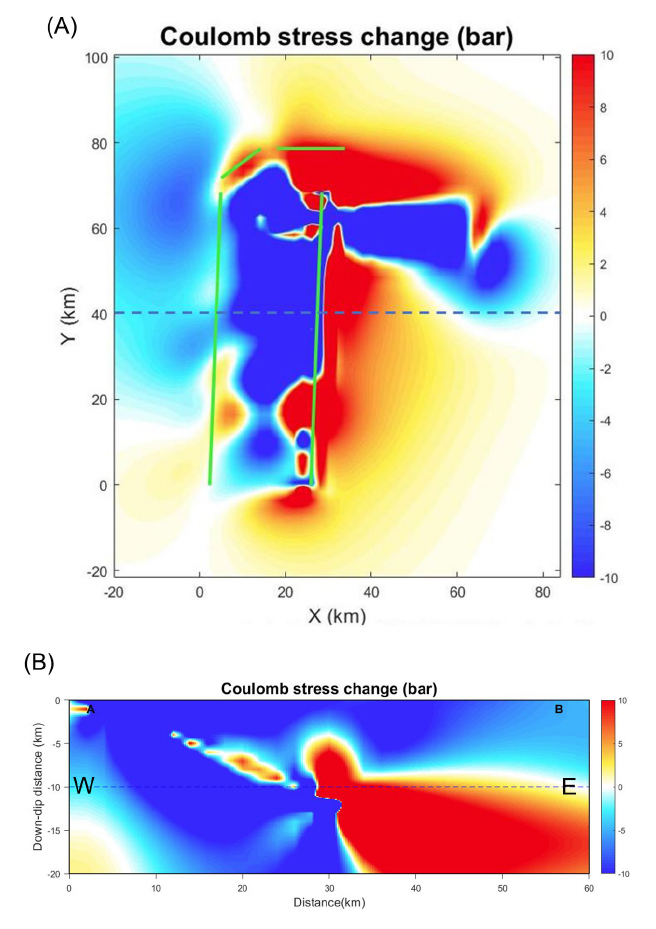
Figure 10. ( A ) Coulomb Stress Changes (CSCs) due to the Chi-Chi earthquake. The green lines are the location of the 4 sub-faults. ( B ) Cross section with location presented on ( A ) by the dashed